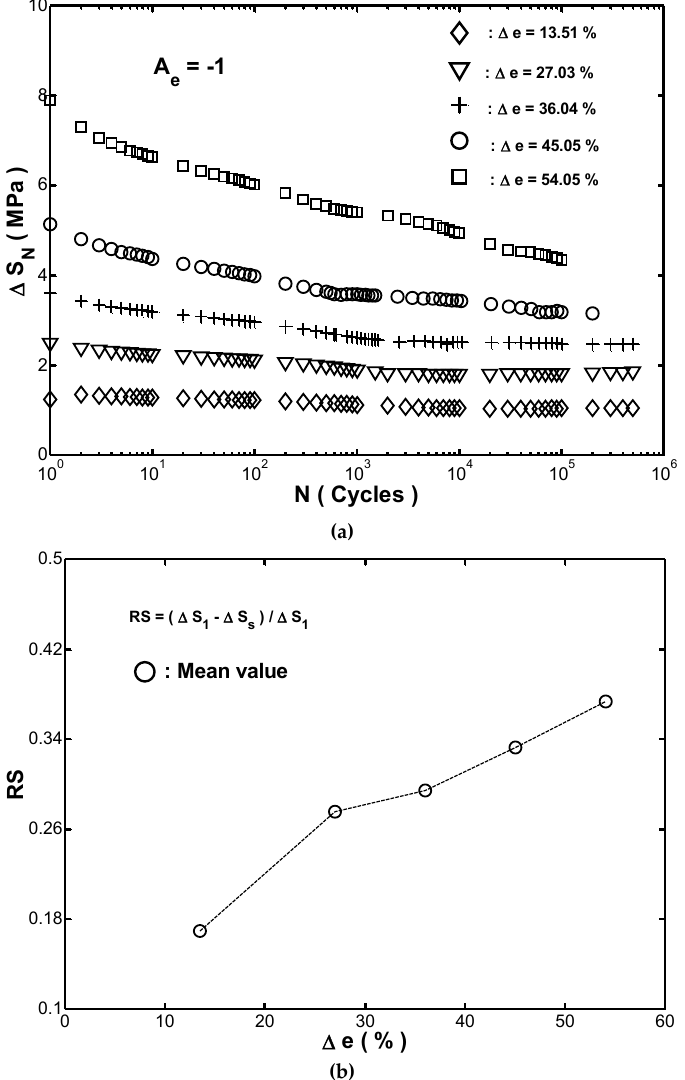
Figure 4. ( a ) Relationship between stress range ( ∆ S N ) and number of cycles ( N ) in cyclic compression testing with five different strain ranges. Note that amplitude ratio was A e = − 1 in every case. ( b ) Variation of softening factor RS with strain range ∆ e in cyclic compression